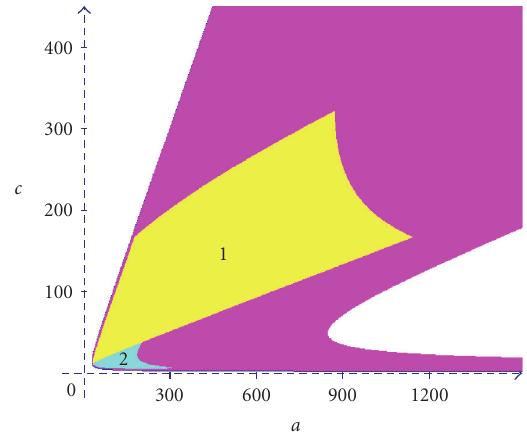
Figure 5.2 . Region of su ffi cient stability condition for (5.2): p = 12, h = 0 . 024, Δ = 0 . 006.